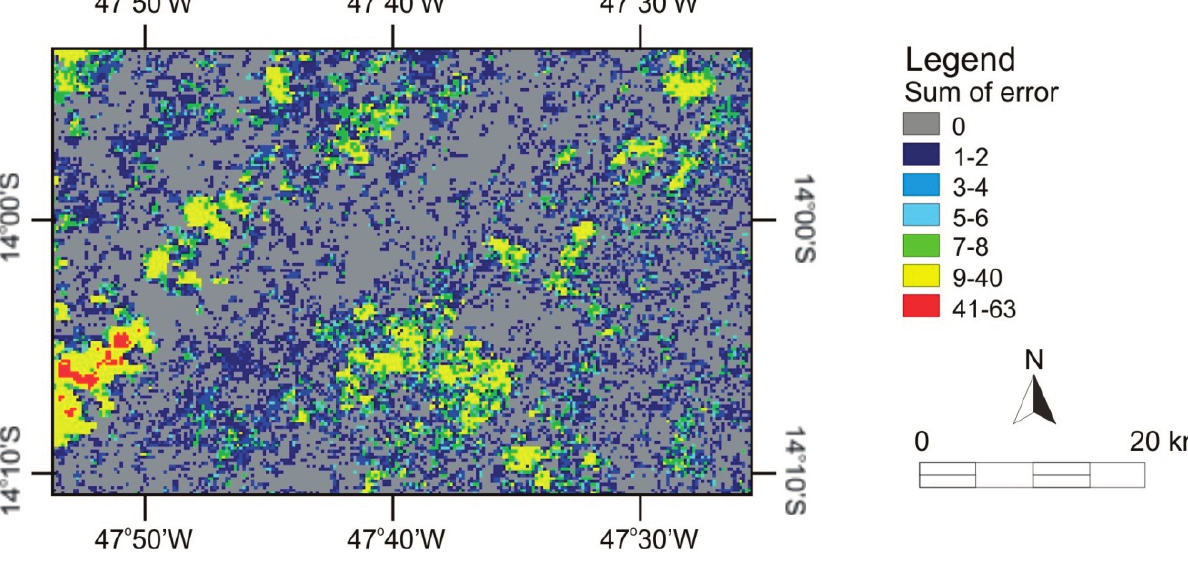
Figure 26 . Error-summation image from interannual phenological deviation in the period 2002 to